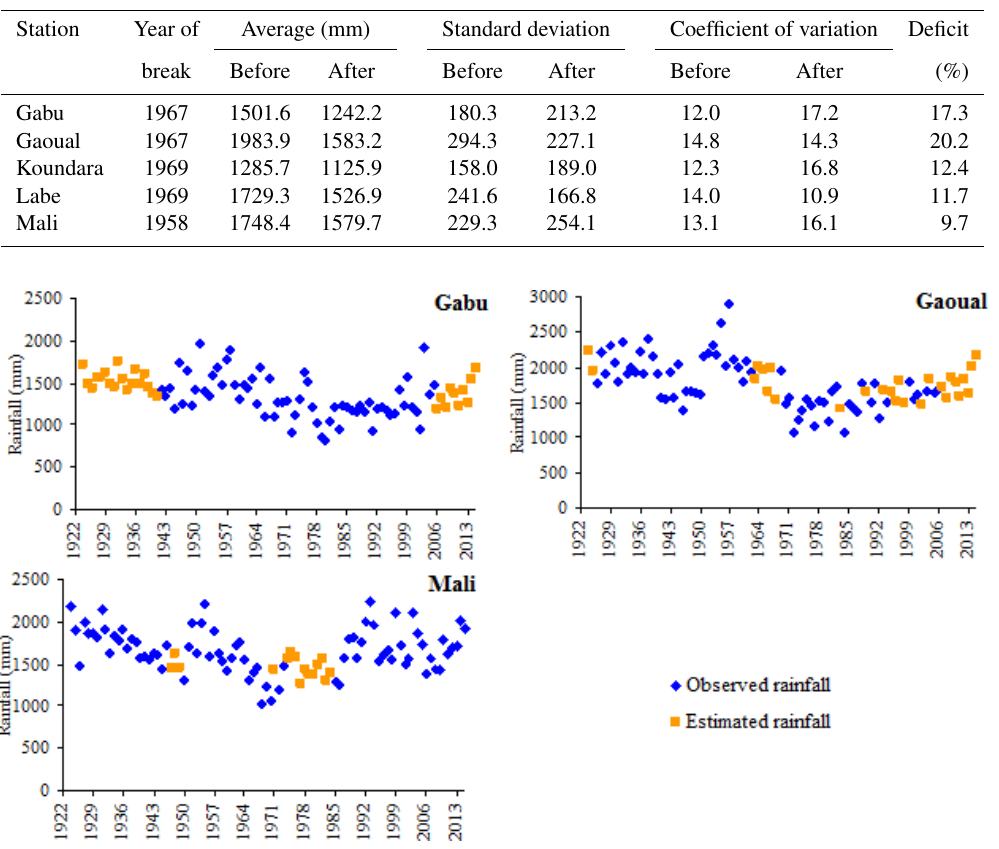
Figure 6. Annual observed and estimated rainfall at Gabu, Gaoual and Mali stations over the period